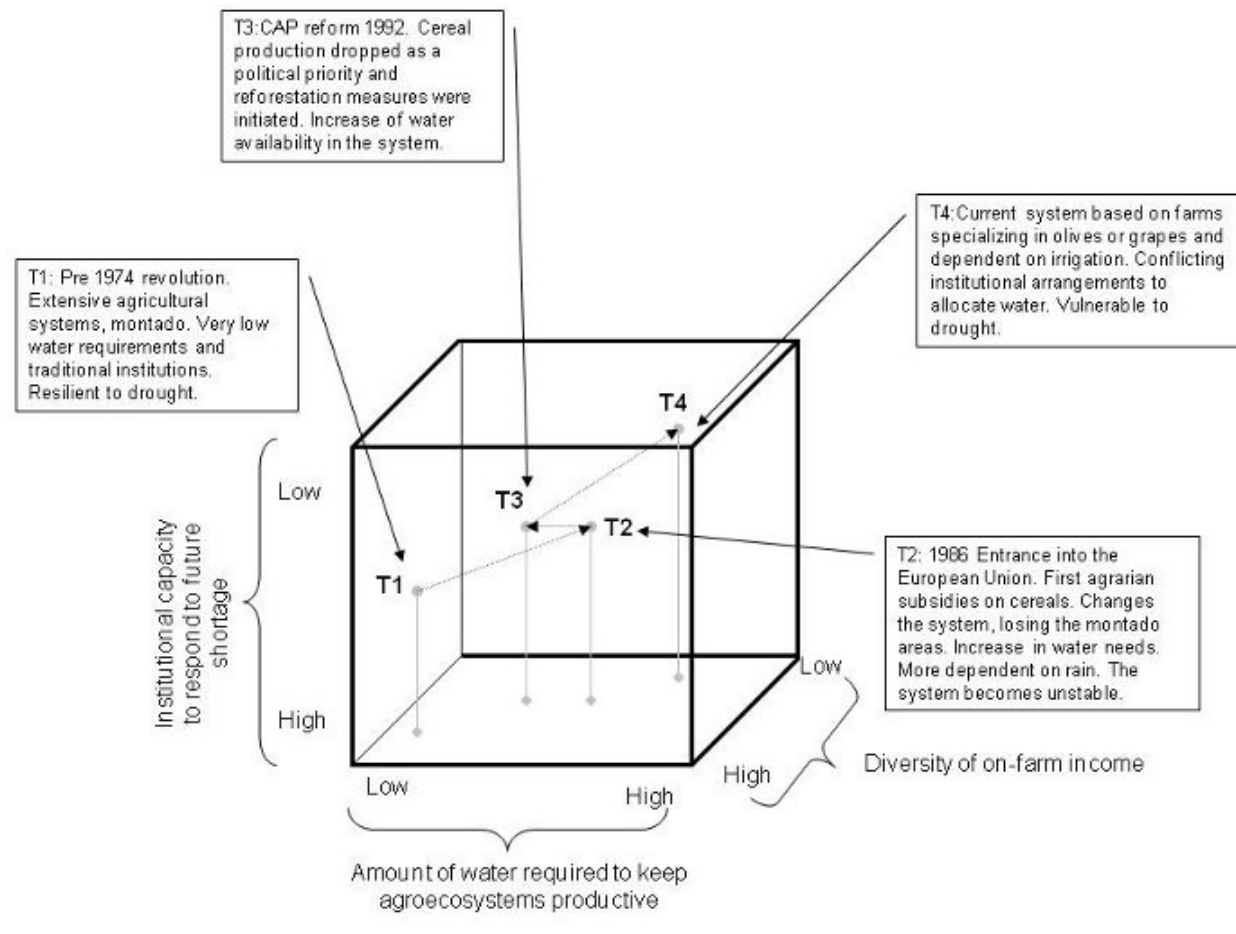
Fig. 6 . Vulnerability analysis suggesting that over time, this rural economy and land-use system has become more vulnerable to water stress (indicated by the movement to the top, right, back corner of the figure) such that smaller droughts will have larger impacts on the local